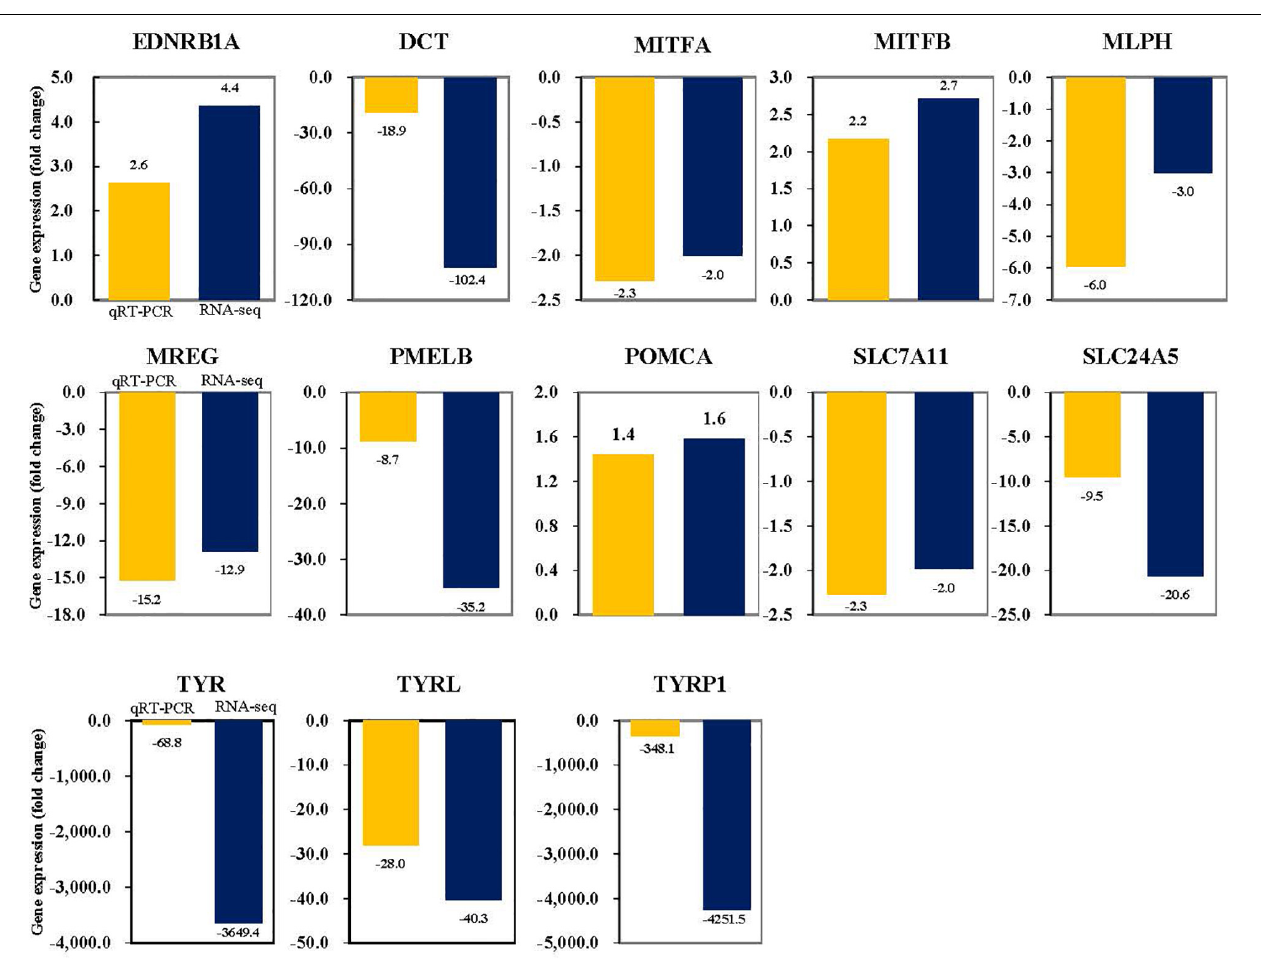
FIGURE 7 | Validation of the RNA-seq FC data by qRT-PCR. Target genes were normalized to the reference gene,